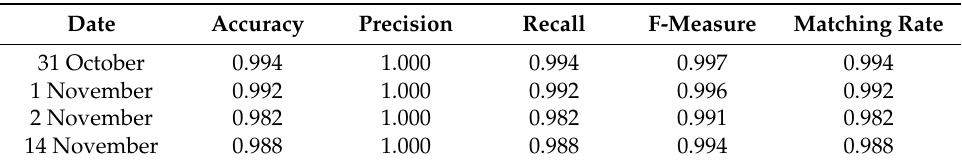
Table 5. Load identification